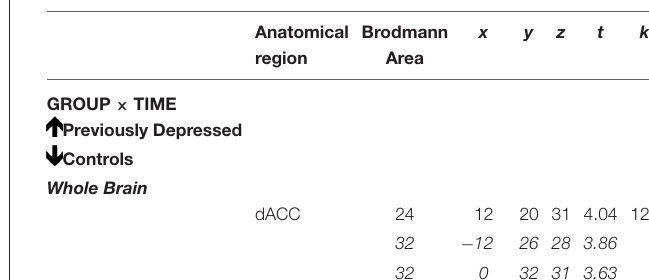
TABLE 2 | Whole brain analyses of group × time interaction reflecting effect where neural activity increases over time in the previously depressed women but decreases in controls.